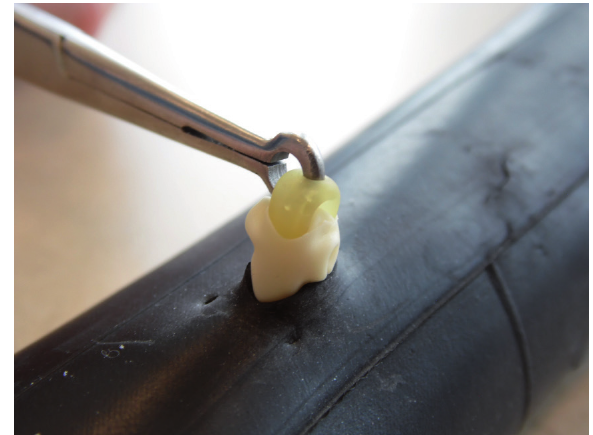
Figure 9 - Grasping the vas with the vas ring